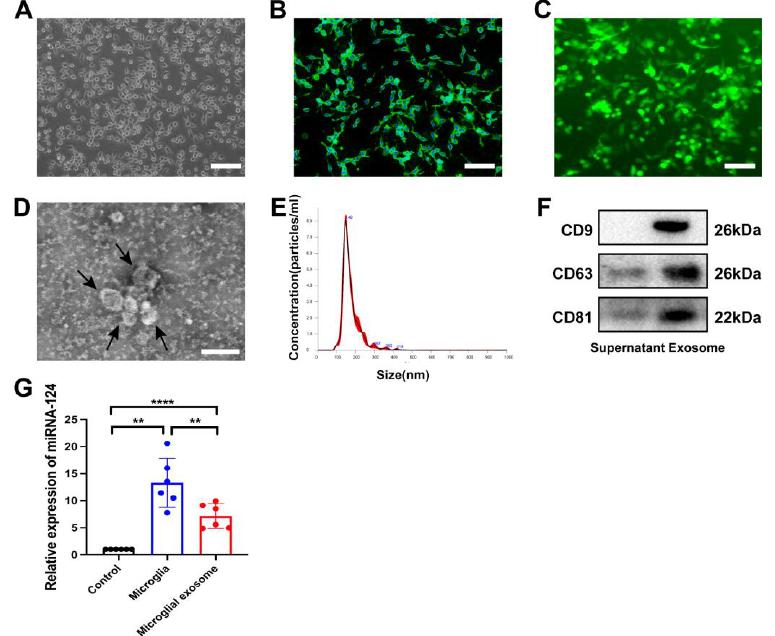
Figure 1. Characteristics of miRNA-124-enriched microglia-derived exosomes. ( A ) Representative light microscope image of cultured BV2 microglia. Scale bar: 200 µm. ( B ) Immunofluorescence staining of Iba-1 (green) and DAPI (blue) to identify microglia. Scale bar: 100 µm. ( C ) Representative image of miRNA-124-GFP (green)-transfected BV2 microglia. Scale bar: 100 µm. ( D ) Representative TEM image of microglia-derived exosomes. The black arrows indicate microglia-derived exosomes. Scale bar: 200 nm. ( E ) The size distribution of the microglia-derived exosomes was determined by a nanoparticle-tracking analyzer. ( F ) Western blot analysis of the levels of characteristic exosome biomarkers, including CD9, CD63 and CD81. ( G ) The bar graphs show the changes in miRNA-124 levels in microglia and microglia-derived exosomes after lentivirus transfection. n = 6/group, mean ± SD, ** p < 0.01,.**** p < 0.0001.